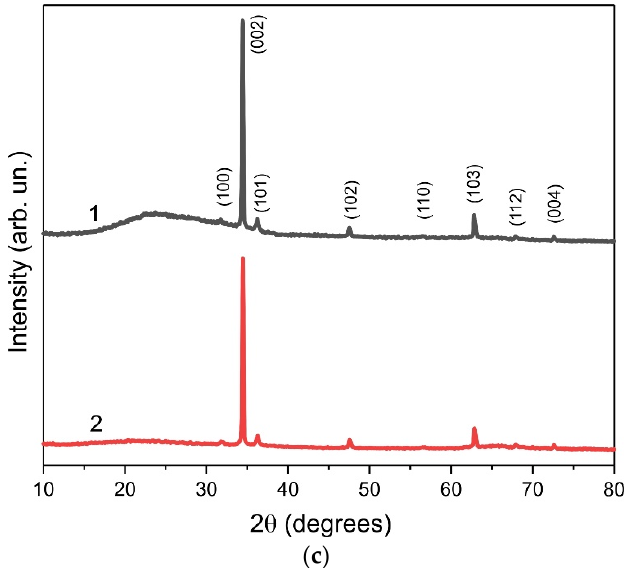
Figure 1. SEM images of ZnO layers synthesized by the CBD method at 90 ◦ C for 60 min of ( a ) ZnO nanorods array grown in 15 mM solution and ( b ) ZnO films grown in 200 mM solution; the size of the images is 4 µm × 4 µm. The inset shows the cross-section of the samples. Scale bars = 1 µm; ( c ) XRD patterns of the obtained ZnO nanorods array (1) and ZnO film (2) on glass substrate.